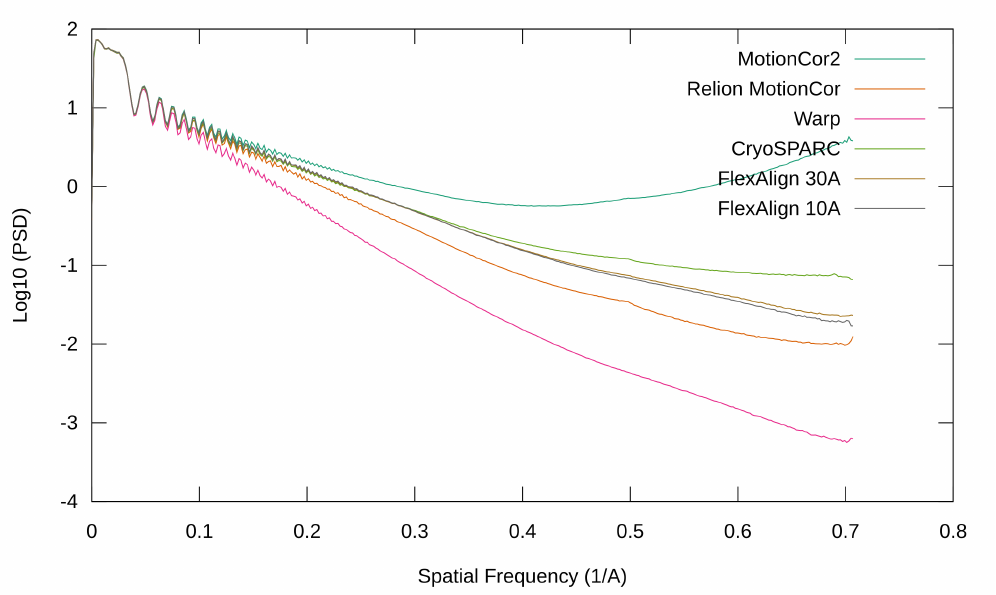
Figure 13. Radial average of the PSD of the produced micrograph using EMPIAR